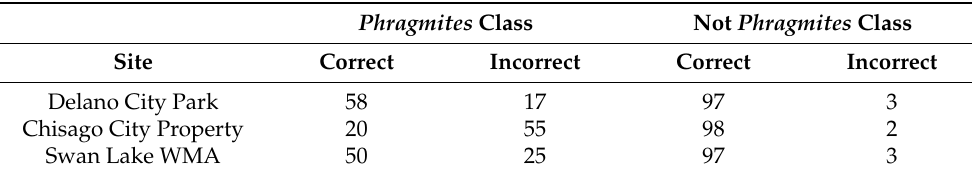
Table 18. Validation assessment points for each of the three validation sites for the support vector machine classification without the post-ML OBIA rule set.